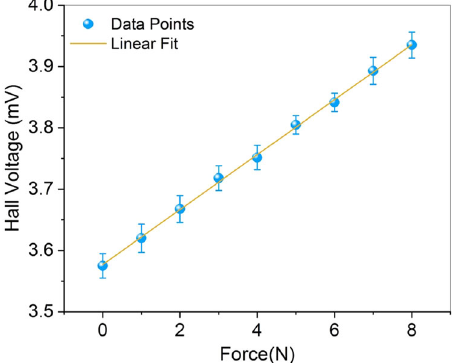
Fig. 8 Average output voltage of fi ve measurements of a soft tactile sensor as a result of consecutive linear loading cycles. The error bars indicate the standard deviation.